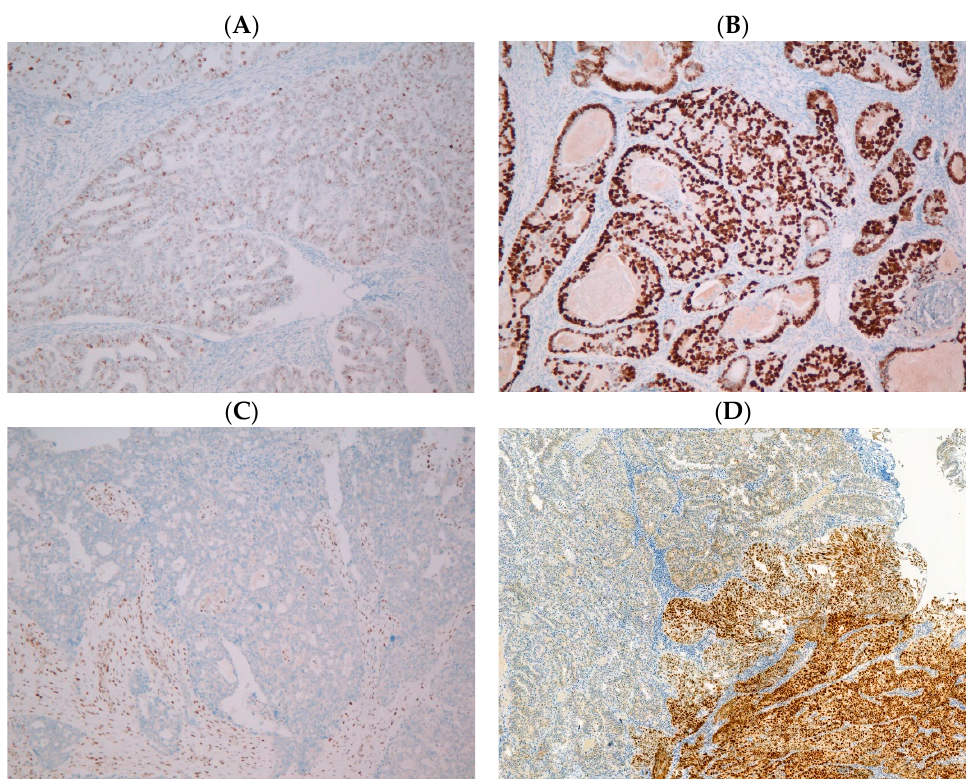
Figure 1. Examples of normal ( A ) and abnormal p53 expression by IHC: nuclear overexpression ( B ), complete absence ( C ) and subclonal patterns ( D ).